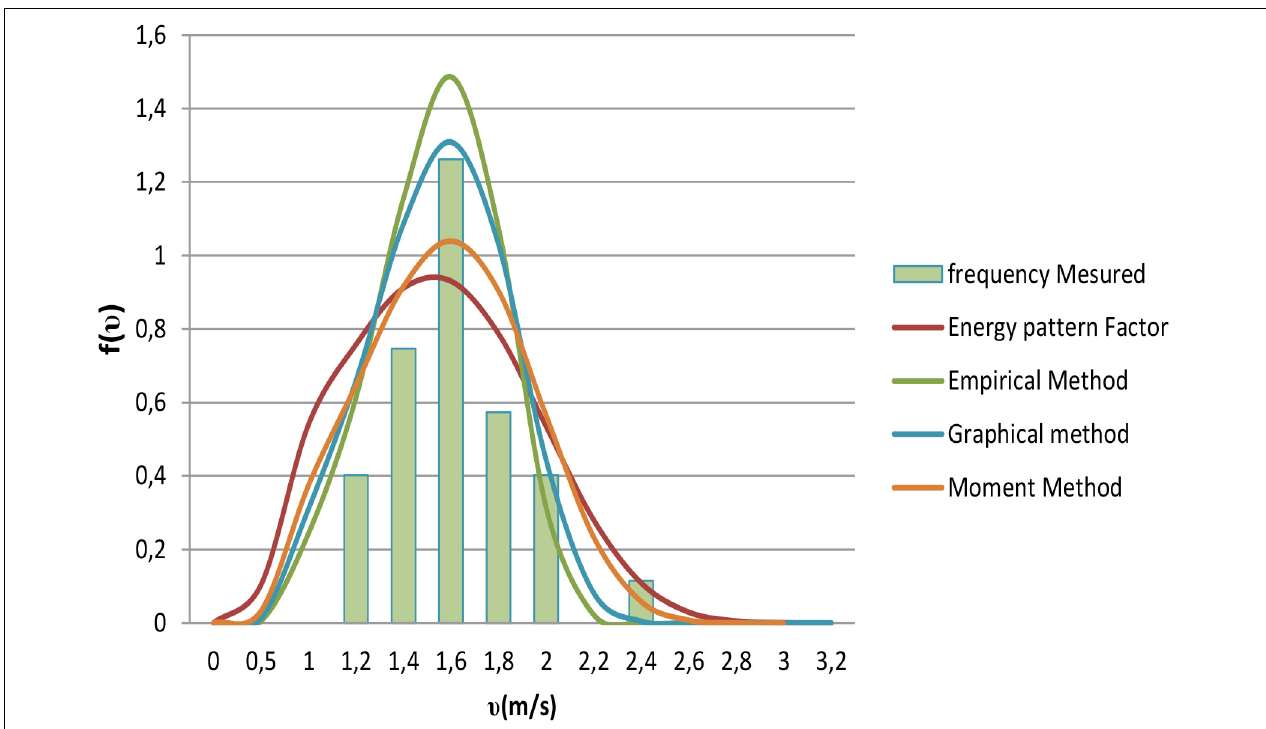
FIGURE 2 | Distribution of Weibull and frequency measured in 2012.